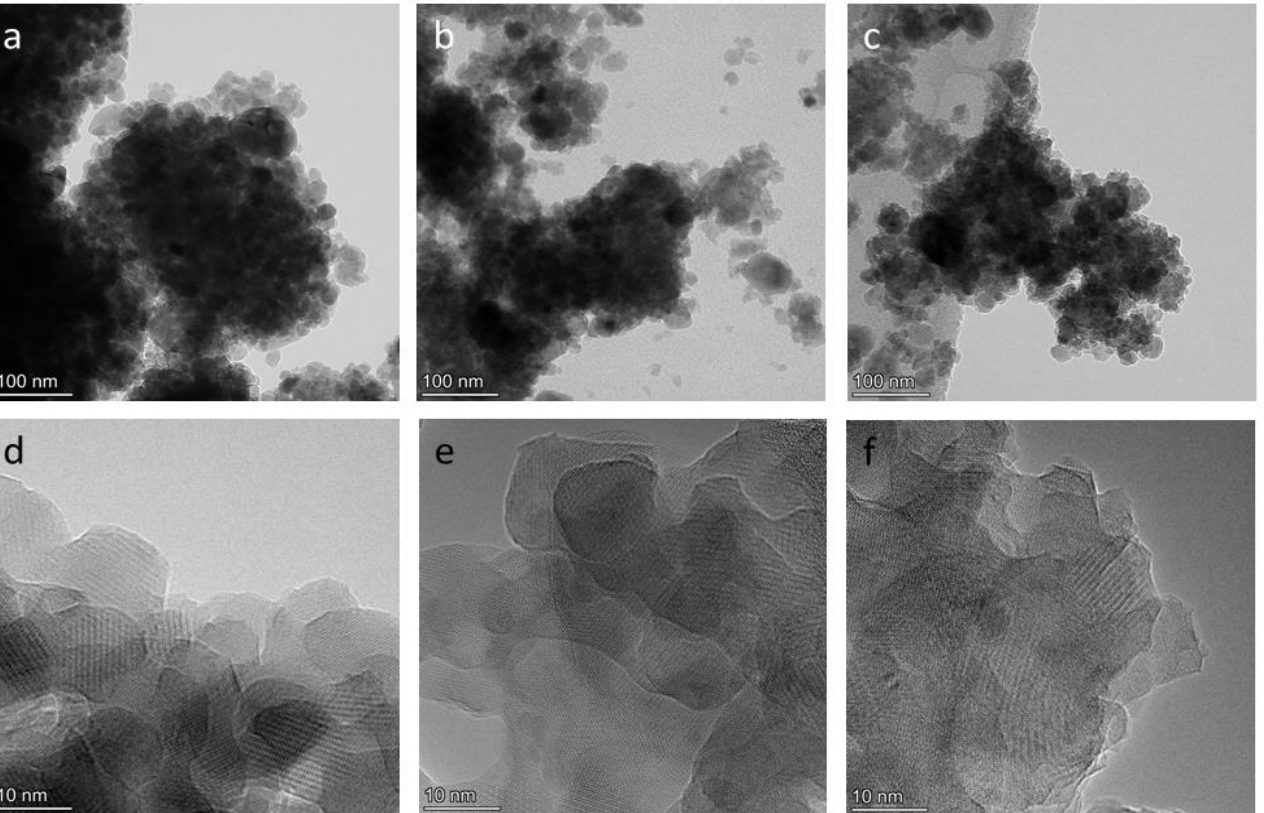
Figure 3. TEM ( a – c ) and HRTEM ( d – f ) images of synthesized samples 0.0Cu ( a , d ), 0.5Cu-Ca ( b , e ), and 0.5Cu-OH ( c , f ).